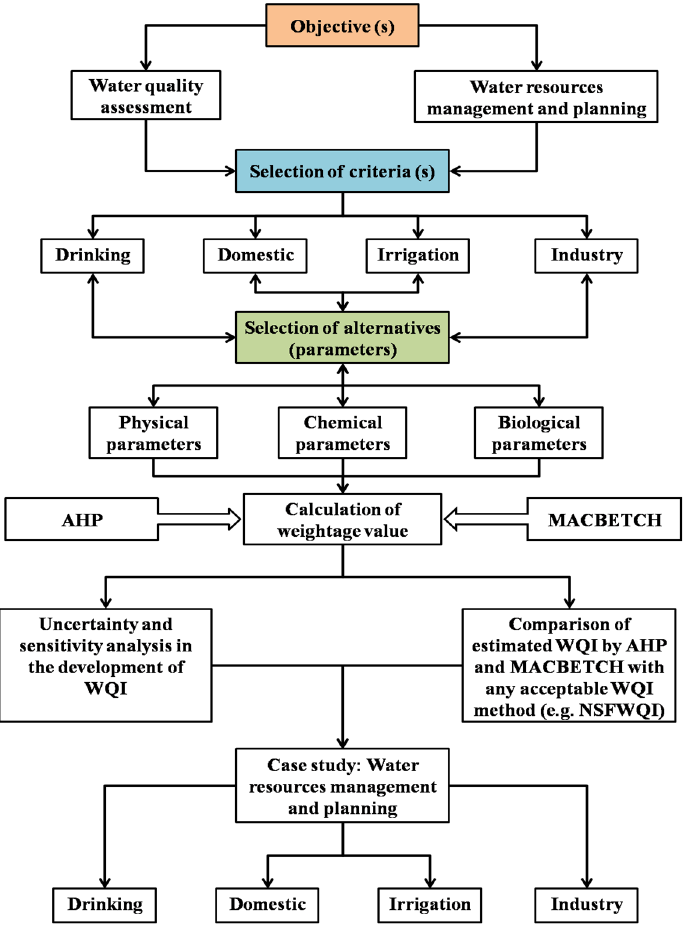
Figure 5. Diagram indicated that the calculation process of WQI with MCDM methods have been discussed step by step.